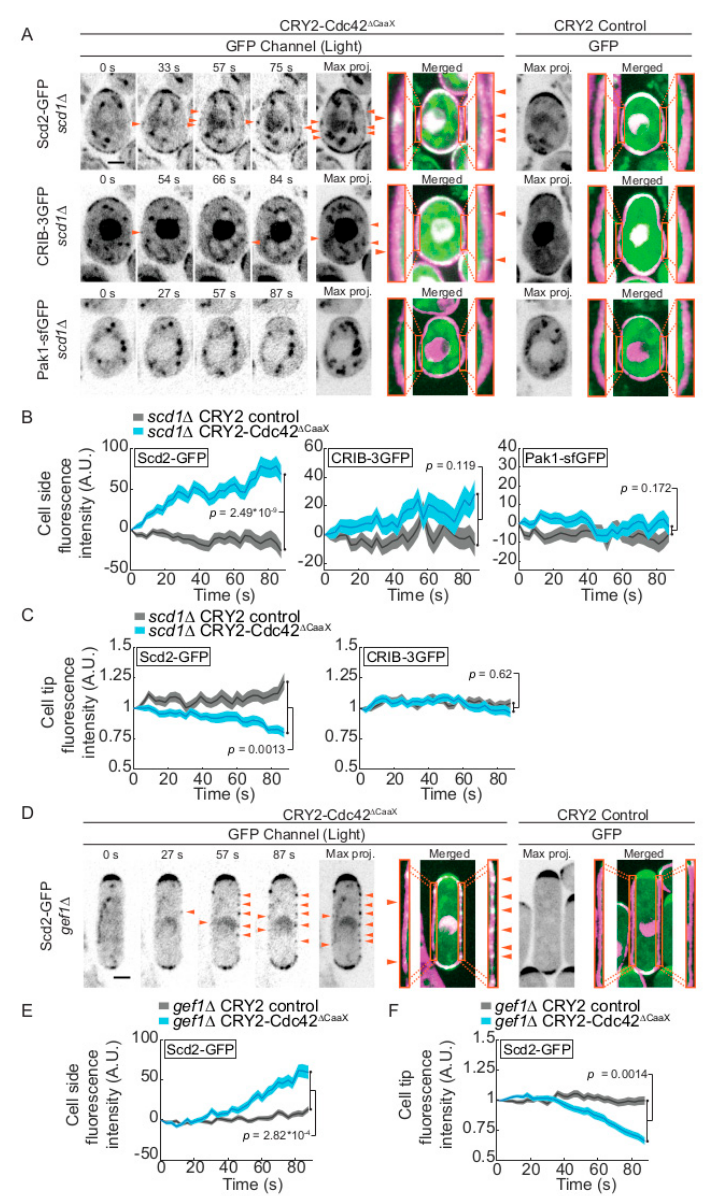
Figure 2. Role of Cdc42 GEFs in activation of CRY2-Cdc42 ∆ CaaX . ( A ) Localization of Scd2-GFP, CRIB-3GFP and Pak1-sfGFP in CRY2-Cdc42 ∆ CaaX -expressing scd1 ∆ cells (B / W inverted images and green channel in merge). The GFP max projection (“max proj.”) images show GFP maximum-intensity projections of 30 time points over 87 s. Merged images are composites of GFP and RFP max projections (t0 omitted from the RFP projection). Magnification of the lateral cortex is shown in the orange insets. Arrowheads point to lateral Scd2-GFP and CRIB-3GFP signal. ( B ) Quantification of GFP signal intensities of Scd2-GFP, CRIB-3GFP and Pak1-sfGFP at cell sides of scd1 ∆ mutants. n > 66 cells. Exact numbers are listed in the methods. ( C ) Quantification of Scd2-GFP and CRIB-3GFP signal intensity at cell poles of scd1 ∆ mutants. n > 62 cells. Exact numbers are listed in the methods. ( D ) Localization of Scd2-GFP in CRY2-Cdc42 ∆ CaaX -expressing gef1 ∆ cells. Layout as in panel A. ( E , F ) Quantification of Scd2-GFP signal intensity at cell sides ( E ) and cell poles ( F ) of gef1 ∆ mutants. n > 68 cells. Exact numbers are listed in the methods. In all graphs, thick line = average; shaded area = standard error of the mean (SEM); WT, wild type; A.U., arbitrary units. Bars = 2 µ m. Associated trace analysis is shown in Figure S5. Autofluorescent organelles appear as linear and circular structures in some of the GFP channel